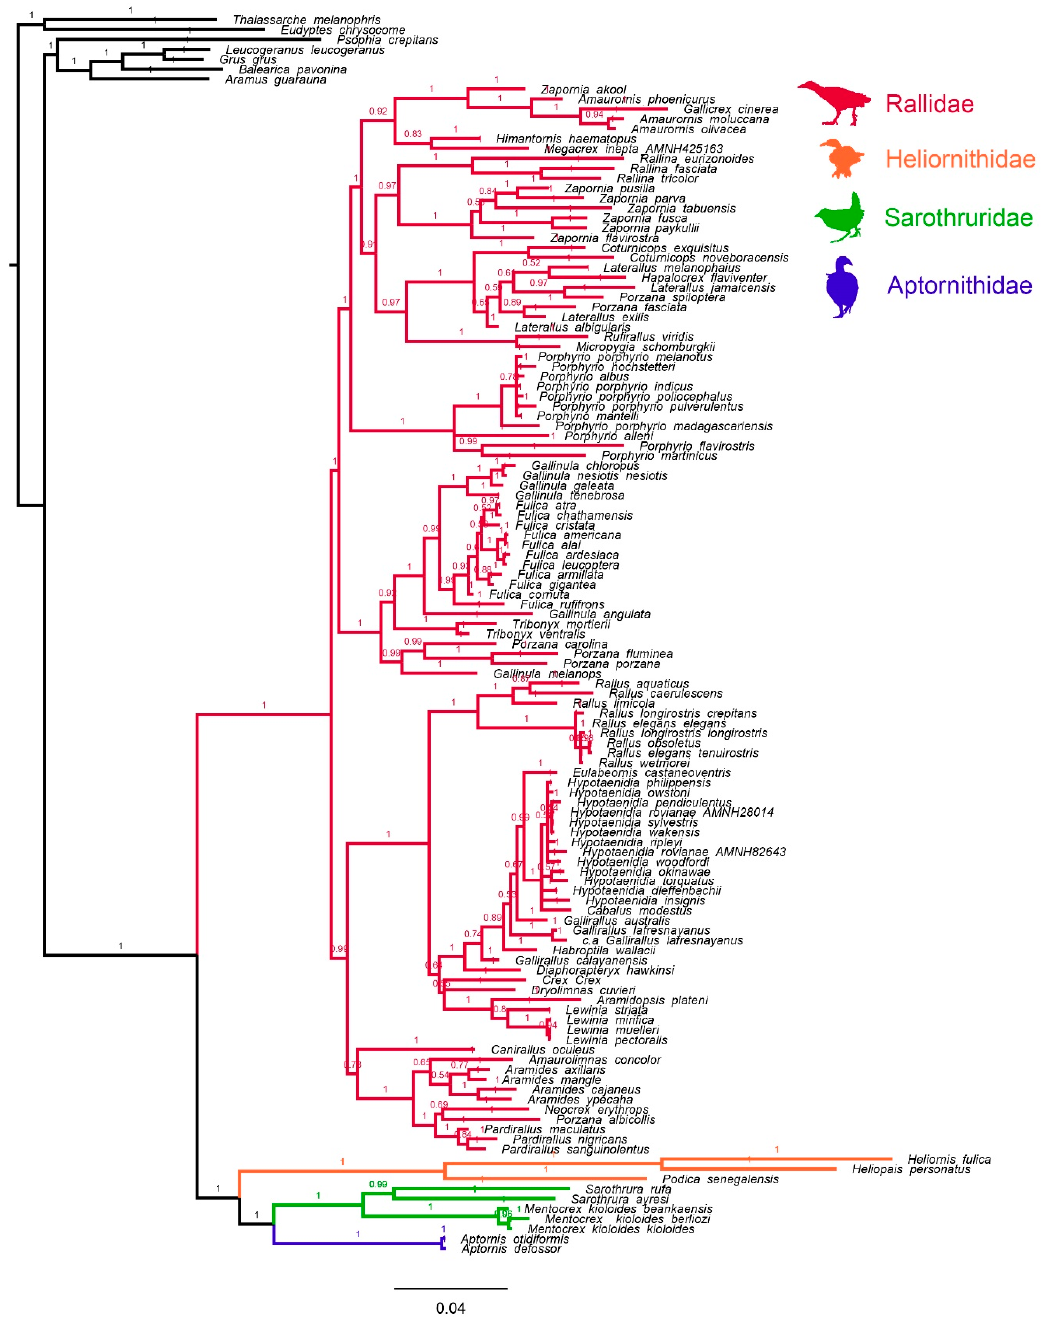
Figure 3. MrBayes maximum clade credibility consensus tree of alignment C. Node numbers represent Bayesian posterior support values.